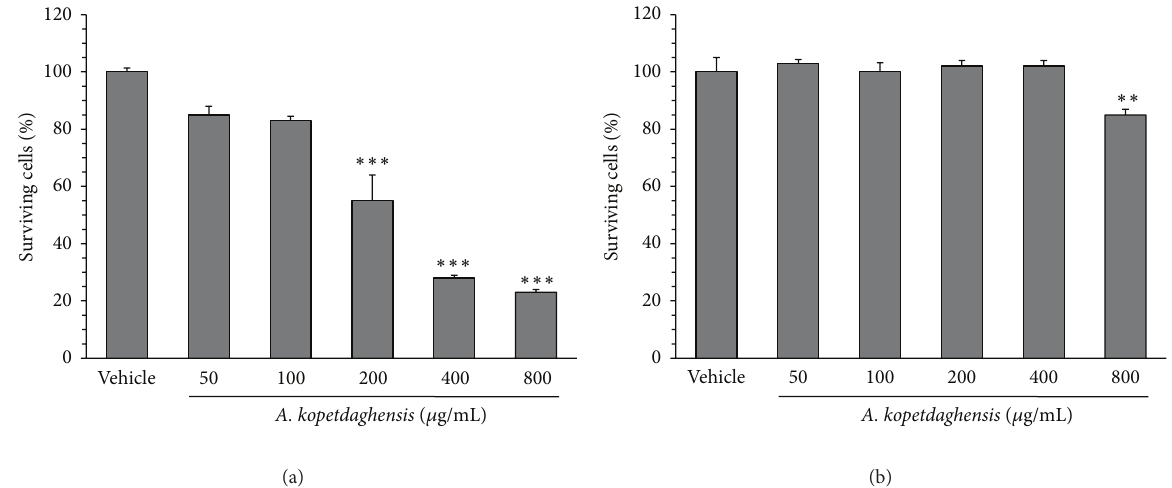
Figure 2: Effect of Artemisia kopetdaghensis hydroalcoholic extract on proliferation of fibroblast L929 (a) and Cho (b) cell lines. The cells were cultured for 24 h in the medium containing vehicle (1% DMSO) or 50–800 𝜇 g/mL of A. kopetdaghensis extract. Values are mean ± SEM ( 𝑛 = 8